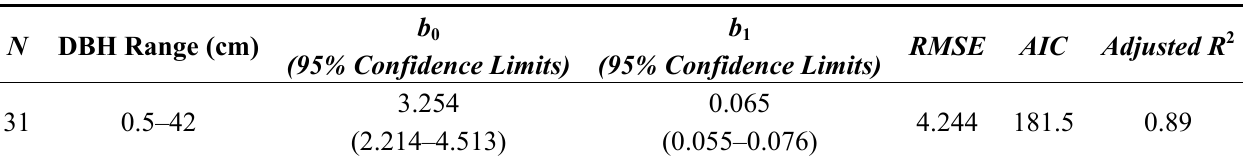
Table 1. Allometric model for predicting above-ground tree biomass of mangrove at Sofala Bay. N DBH Range